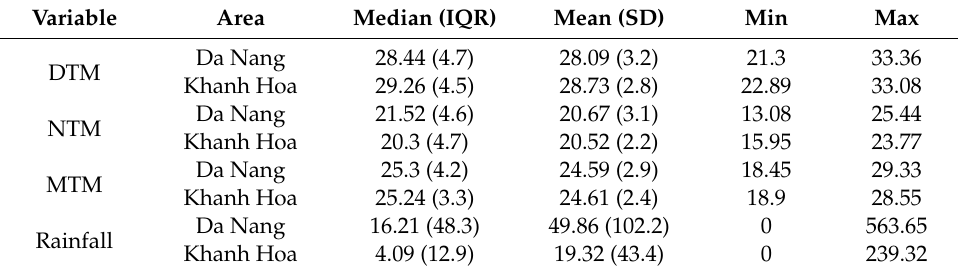
Table 1. Climate variables in Da Nang and Khanh Hoa,